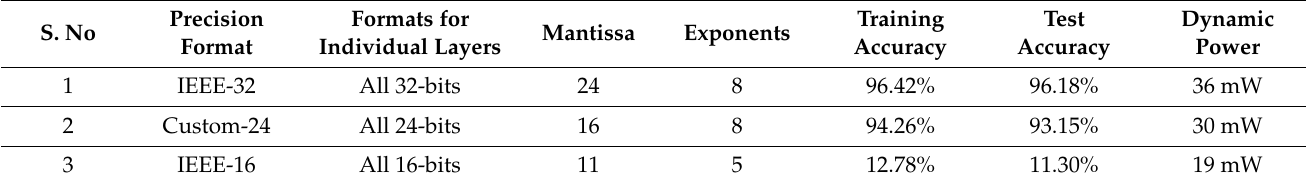
Table 3. Comparison of accuracy and dynamic power for different